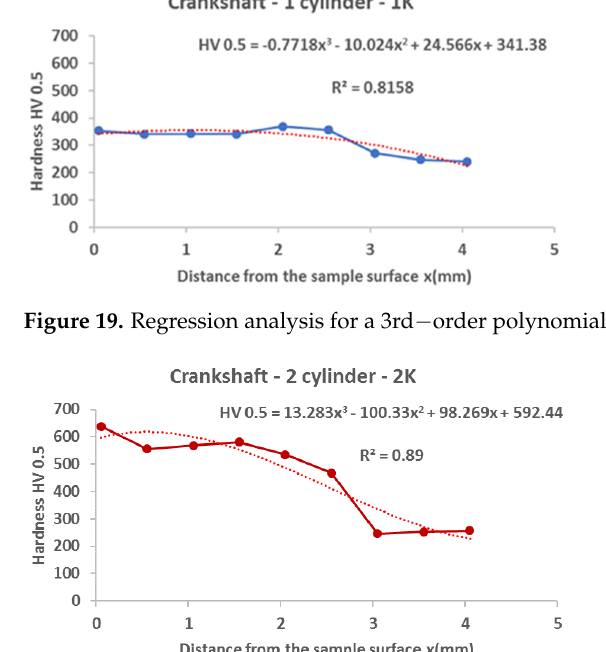
Figure 22. Regression analysis for a 3rd − order polynomial for crankshaft values on 4th cylinder. 3.4. Results of Microscopic Analysis When verifying the experiments from the point of view of the surface microstructure, with a new cam and the used cam, we used a confocal microscope with laser 3D scanning, which is suitable not only for monitoring the roughness profile but also for observing the